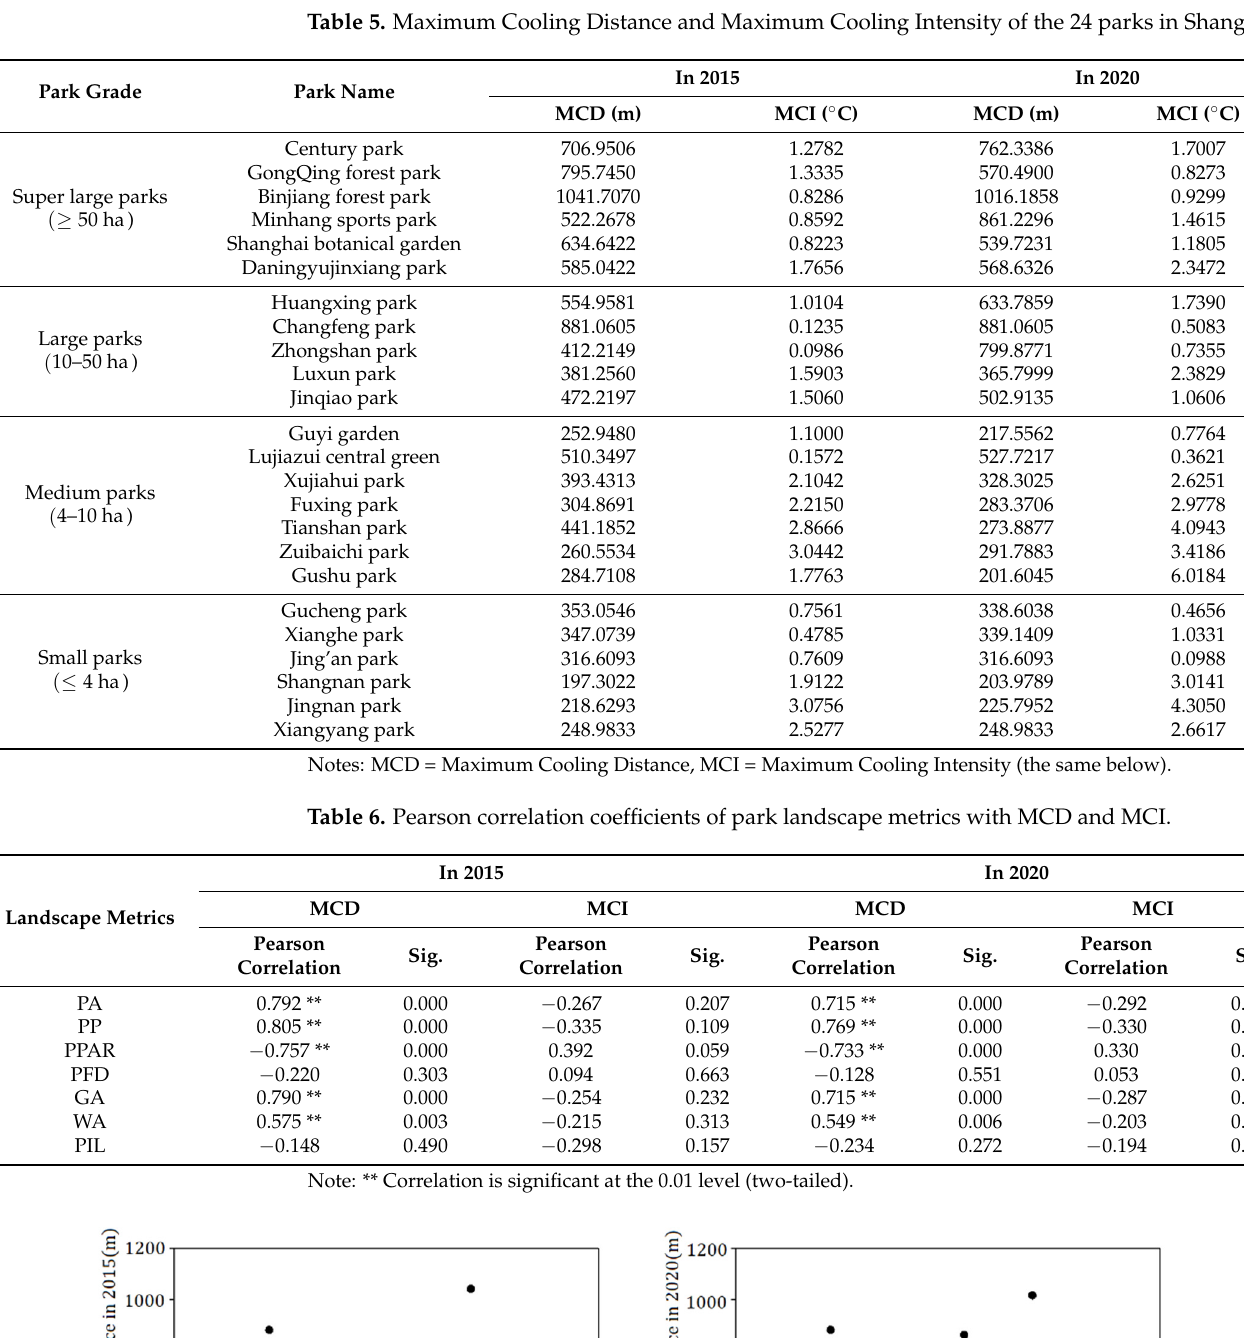
Table 5. Maximum Cooling Distance and Maximum Cooling Intensity of the 24 parks in Shanghai.